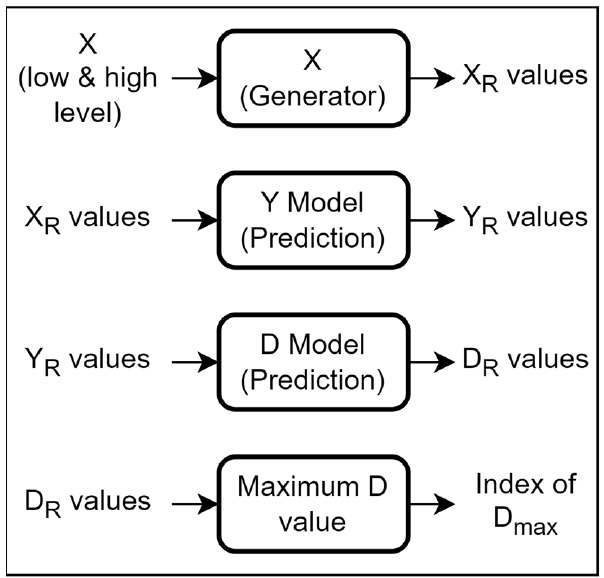
Figure 16. Final Optimization pipeline. Table 3. Comparison of the obtained optimized X values (x 1 , x 2 , …, x 8 ) using the proposed method with those reported in [17]. The corresponding Y values (y 1 , y 2 , …, y 5 ) are also listed.